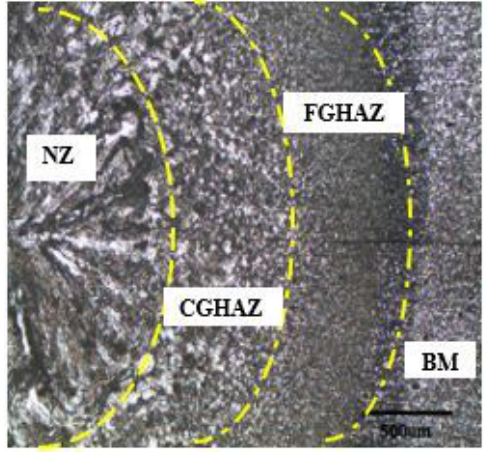
Figure 10: Optical microstructure of weld nugget of RSW AHSS- DP800 joints showing NZ, CG-HAZ, FG-HAZ and BM